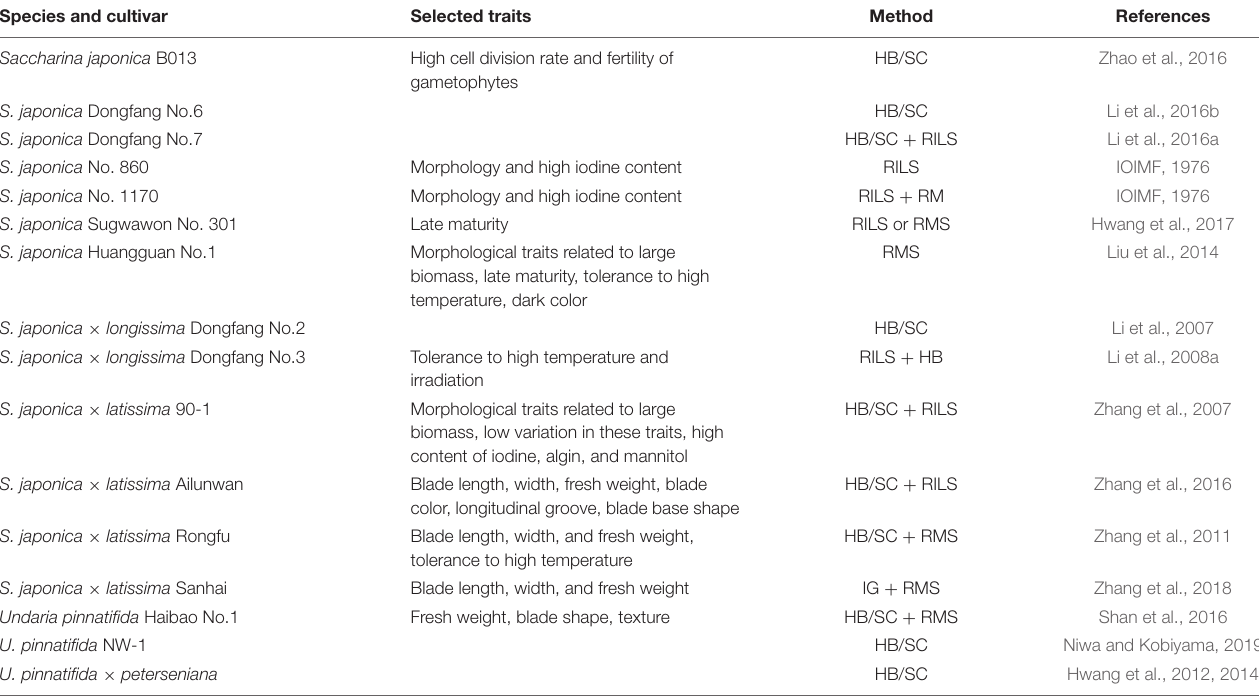
TABLE 1 | Published examples of breeding of kelp cultivars (all belonging to the Laminariales). Species and